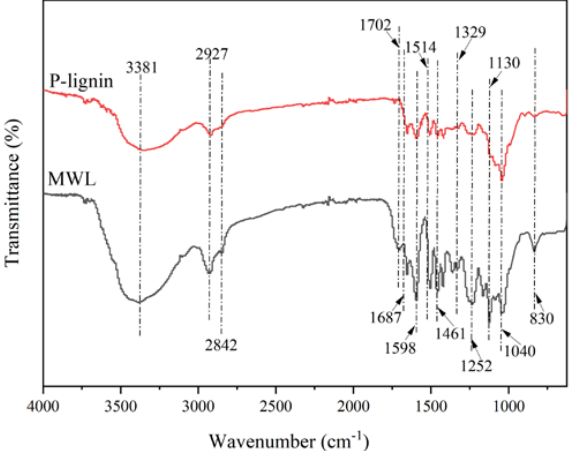
Figure 6. FTIR spectra of MWL and P-lignin (extracted at optimal pretreatment conditions).